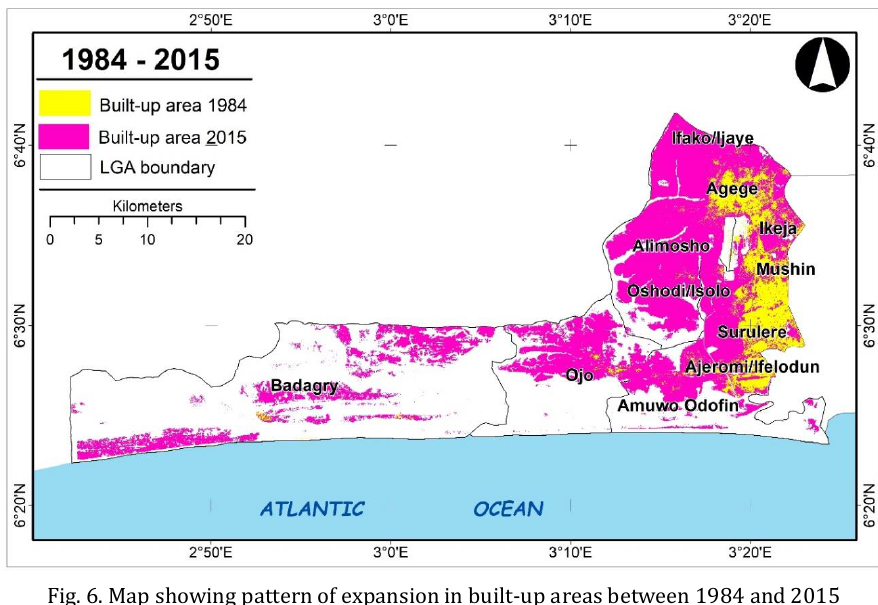
Fig. 6. Map showing pattern of expansion in built-up areas between 1984 and 2015